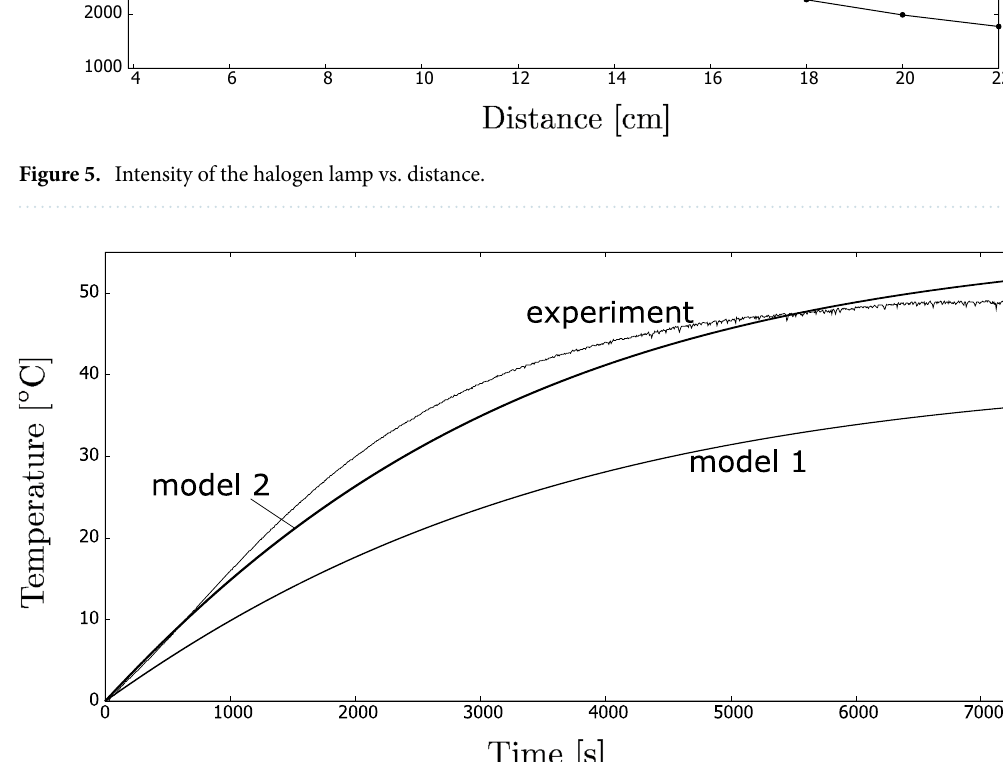
Figure 6. History of temperature increase (an example) for the coffee colloid sample during the indoor experiments. The results also validate the two mathematical models discussed in “Theoretical analysis”